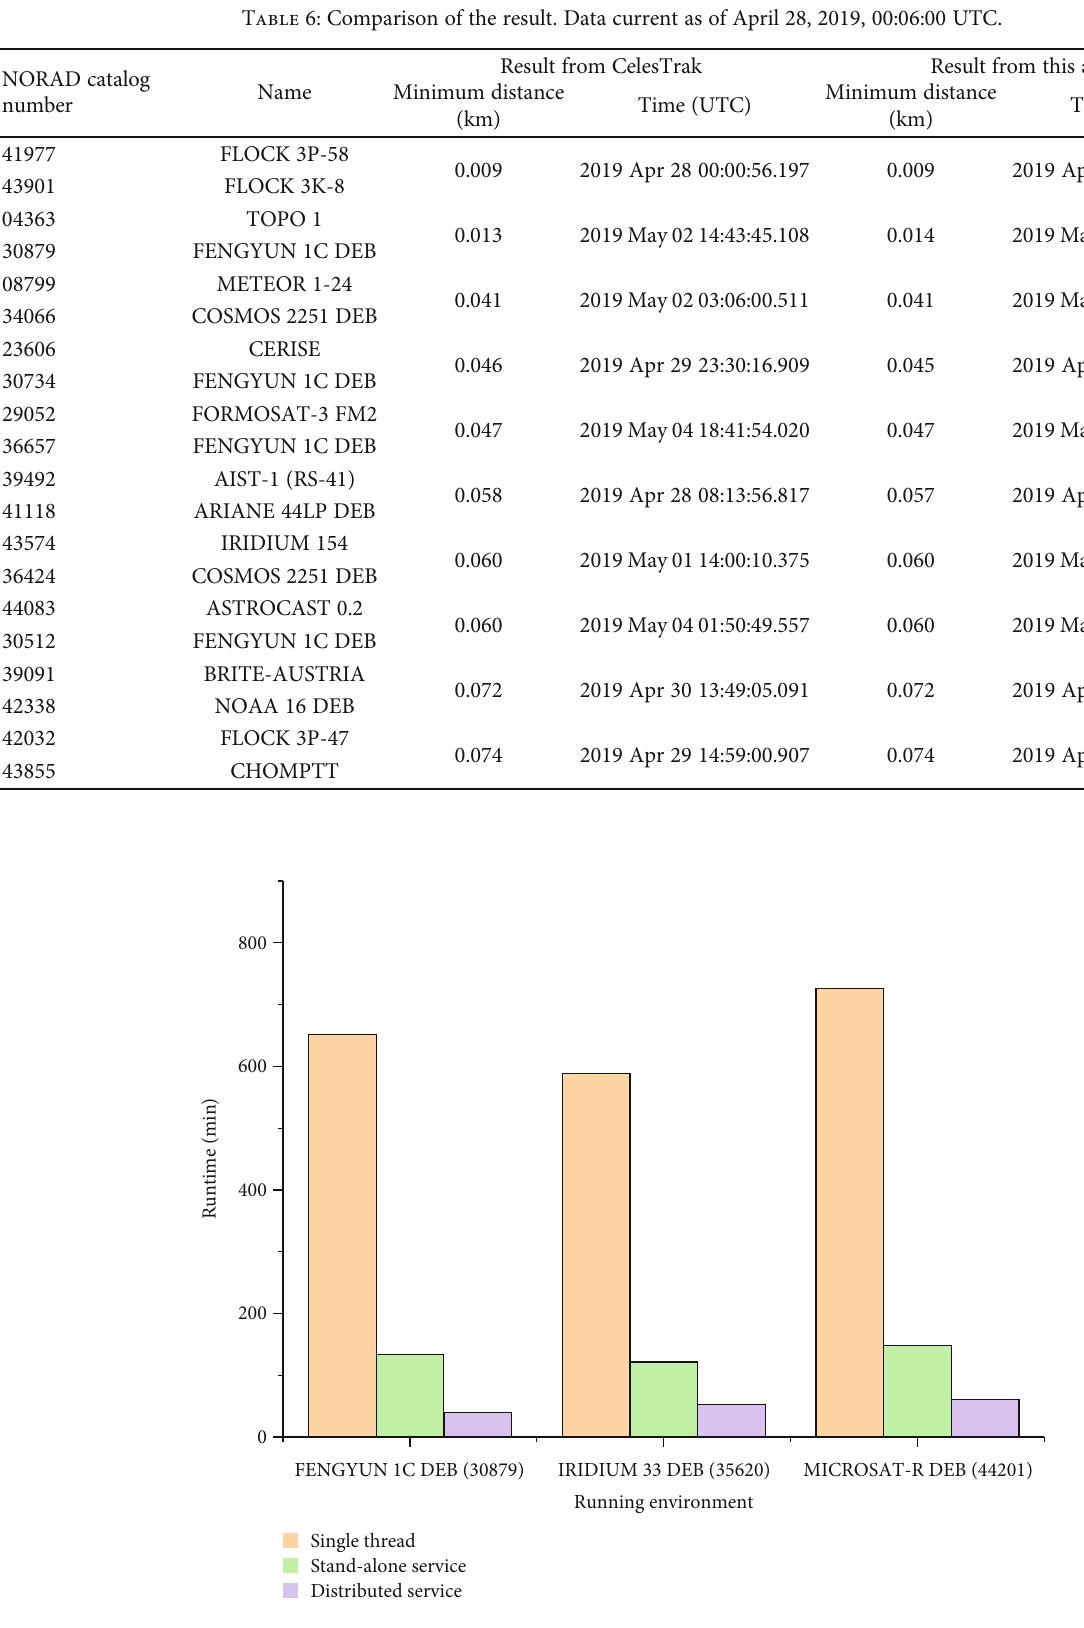
Figure 16: The runtime of one-to-all conjunction assessment in di ff erent running